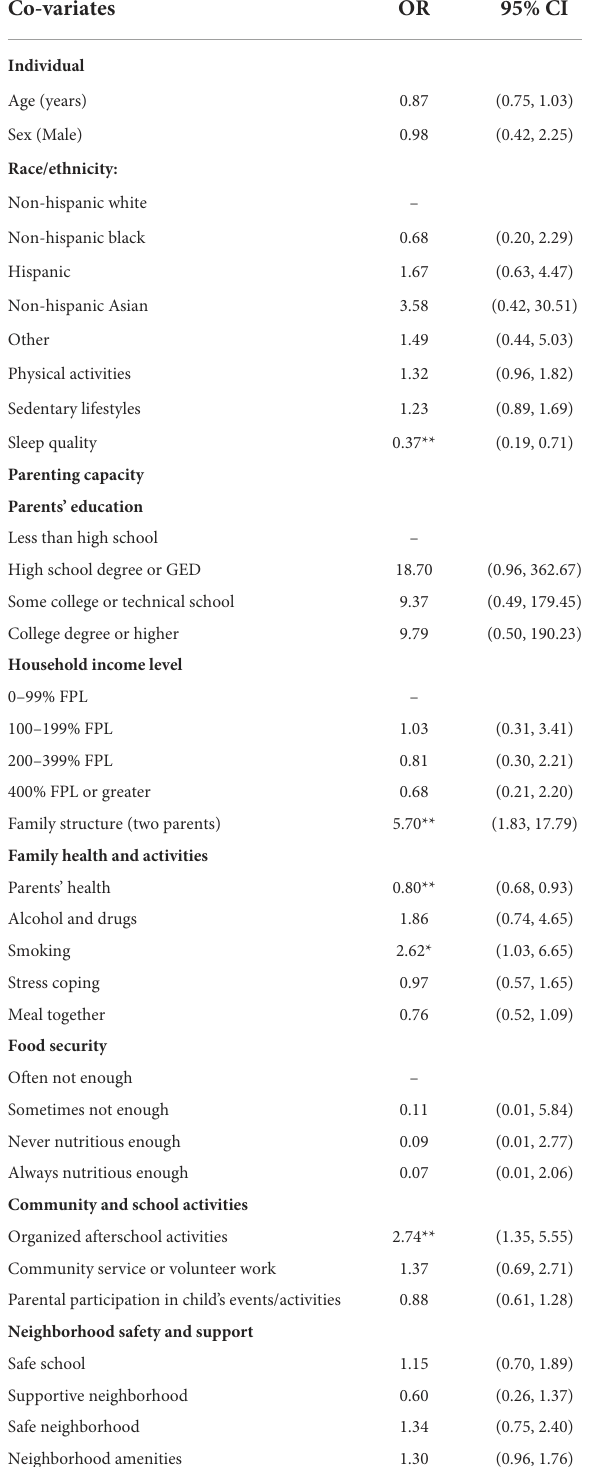
TABLE 2 Weighted multivariate logistic regression